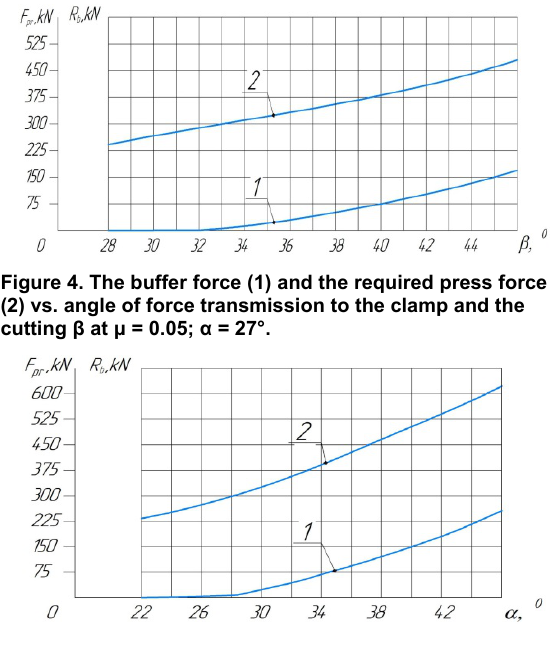
Figure 5. Buffer force (1) and the required press force (2) vs. angle of force transmission to the clamp and the cutting α at μ = 0.05; α =